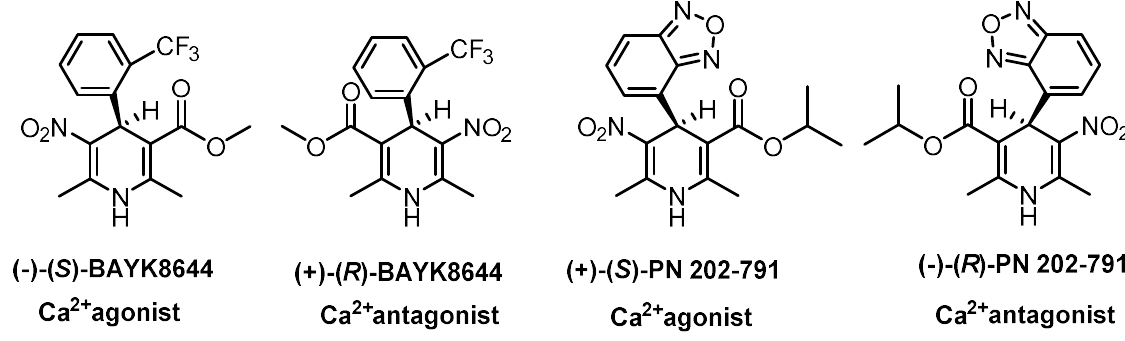
Figure 3. Opposite effects of 1,4-dihyropyridine derivatives on function of L -type channels.